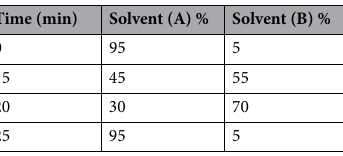
Table 1. Gradient programmode for isolation of the bioactive compounds of pomegranate peel extract.